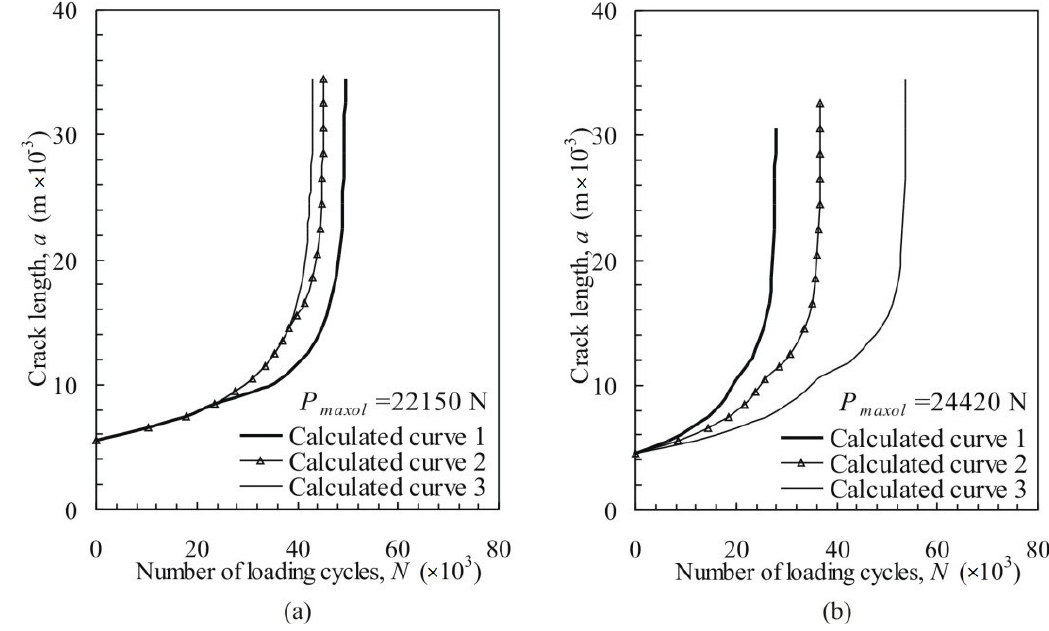
Figure 4. Fatigue resistance analysis: ( a ) a versus N (1 − a ol = 8.5 mm, 2 − a ol = 14.5 mm, 3 − a ol = 24.5 mm) and ( b ) a versus N (1 − R = 0.1, 2 − R = 0.3, 3 − R = 0.5), calculated curves from the present work.